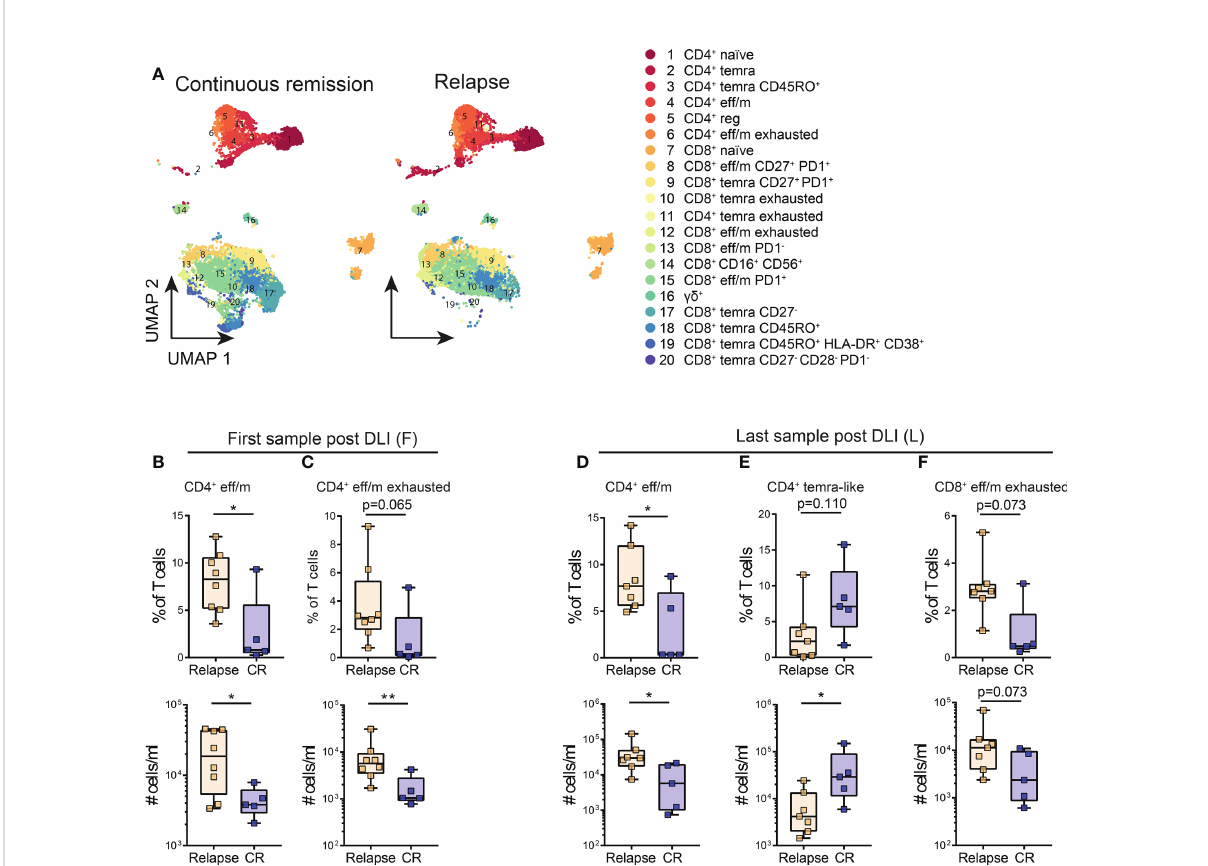
FIGURE 3 Lower levels of exhausted T cell clusters are associated with continuous remission early and late post DLI. (A) Cluster analysis identi fi ed 20 different T cell populations within the post-DLI samples. These are shown in Uniform Manifold Approximation and Projection (UMAP) including all samples of patients with continuous remission (n=5) and relapse (n=8) post DLI during the 24 months follow-up. The details on the 20 identi fi ed clusters are listed in Supplementary Table S6. (B, C) Comparison of frequencies and cell counts of two clusters identi fi ed in